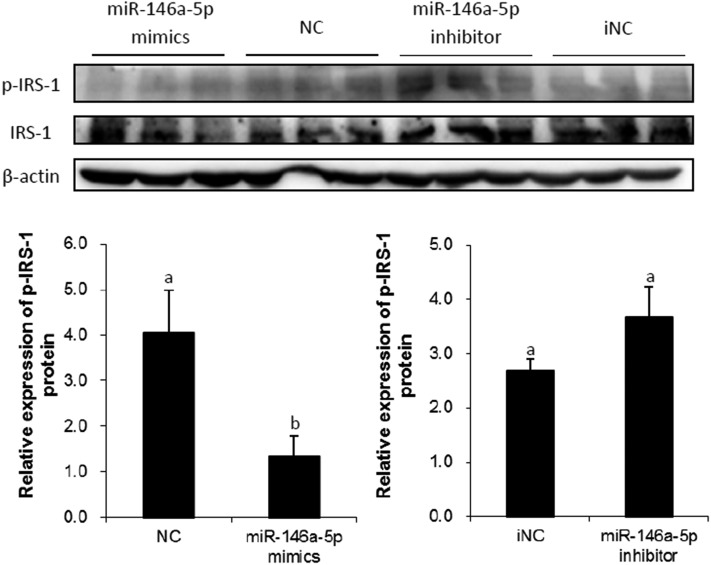
Western blot analysis of tyrosine phosphorylation of IRS-1. Preadipocytes were transfected with miR-146a-5p mimics/NC/inhibitor/iNC, and tyrosine phosphorylation of IRS-1 was assayed on induction day 8 after treating with 100 nM insulin for 1 h at 37°C. IRS-1 was used to adjust the expression of tyrosine phosphorylation of IRS-1. The means in each column followed by the different letters represent significant difference (P < 0.05), and the same letter represents nonsignificant difference (P > 0.05, n = 3).